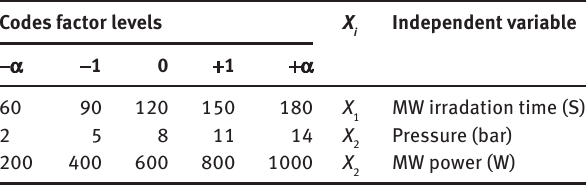
Figure 2: Continuous-flow MW reactor for biodiesel production.